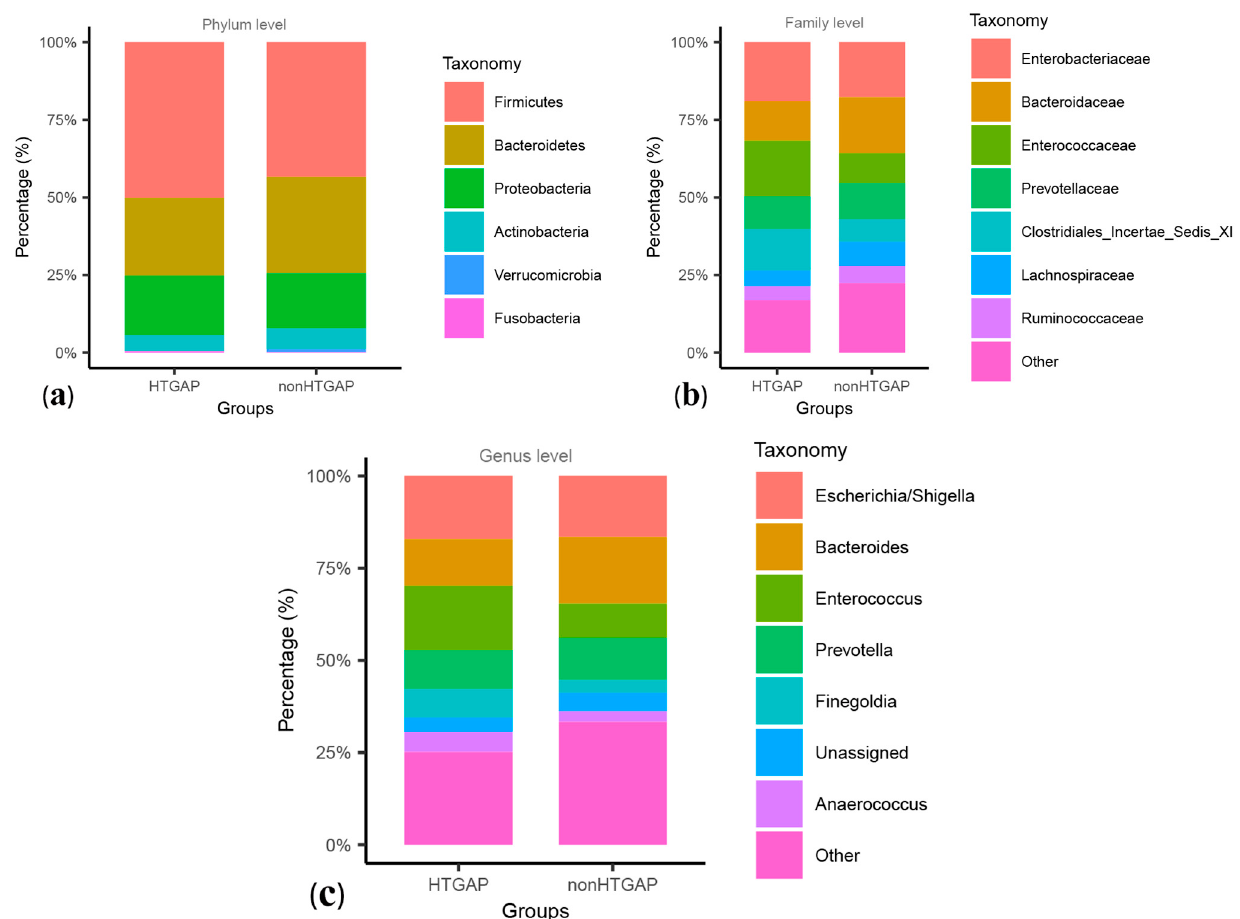
Figure 2. Relative abundances of bacteria between groups at the phylum ( a ), family ( b ), and genus ( c ) levels. Bacteria that below 1.00% in two groups or cannot be assigned to a specific taxonomic category, were grouped into others. HTGAP, hypertriglyceridemia-associated acute pancreatitis.